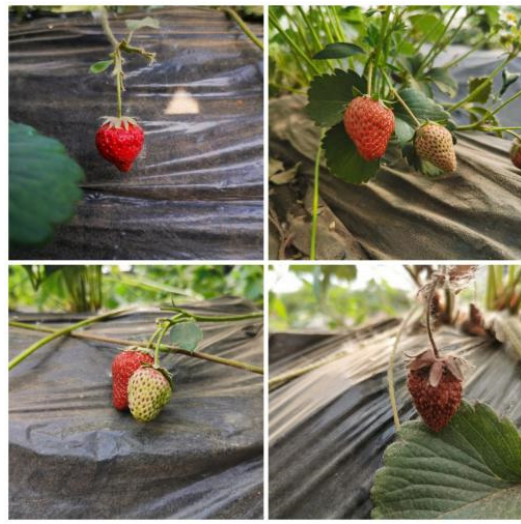
Figure 2. Original dataset of